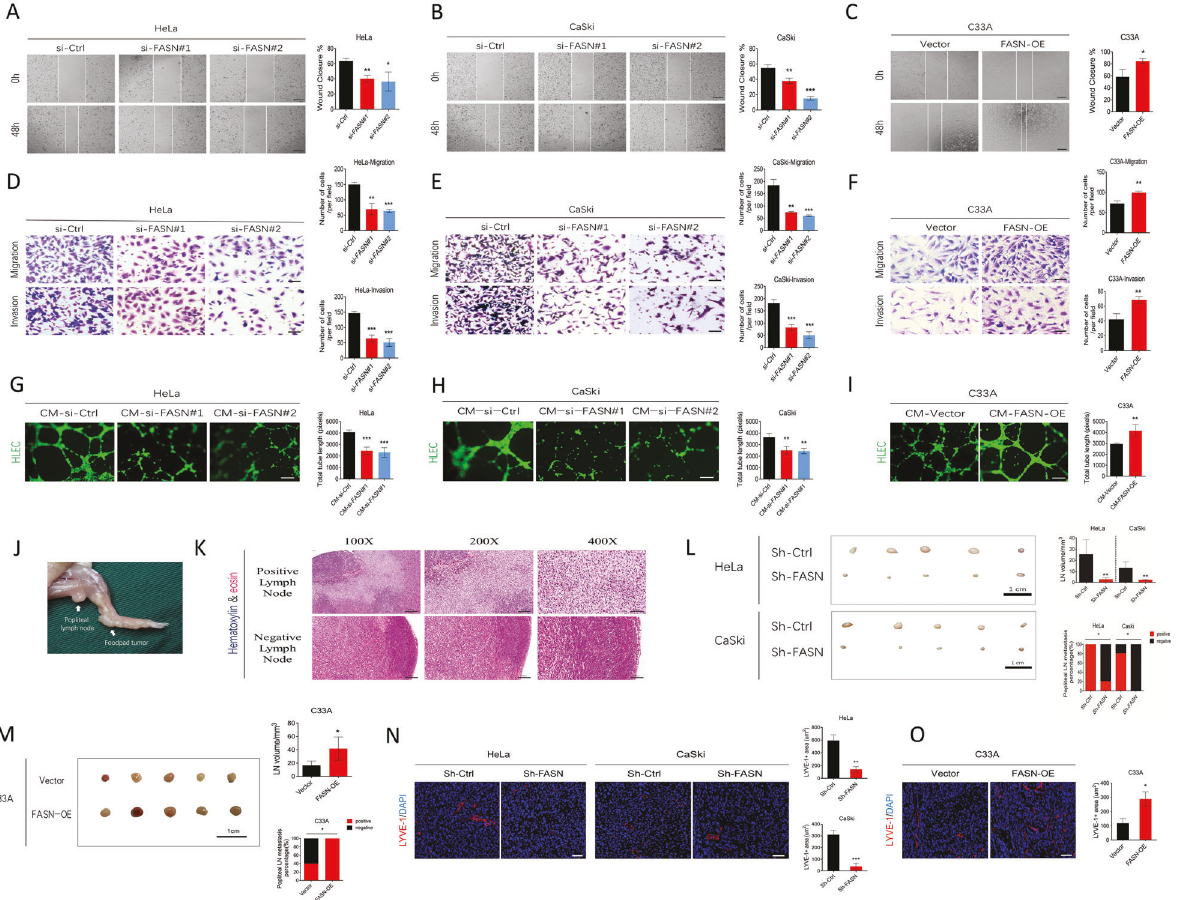
Fig. 3 FASN promotes cervical cancer cell migration, invasion, lymphangiogenesis in vitro, and lymph node metastasis in vivo. A , B The wound healing assay results and quanti fi cation in the si-FASN (siRNA#1 and #2) group and si-Ctrl (scramble siRNA) group of HeLa and CaSki cells. Bar = 200 µm. C The wound healing assay results and quanti fi cation in the Vector (empty vector plasmid) group and FASN-OE (FASN overexpression plasmid) group of C33A cells. Bar = 200 µm. D – F Transwell migration and invasion results and corresponding quanti fi cation in the same group settings as A-C in HeLa, CaSki, and C33A cells. Bar = 50 µm. G , H Assessment of lymphangiogenesis by tube formation assays in the CM-si-FASN (FASN siRNA#1 or #2-treated tumor culture medium) and CM-si-Ctrl (control scrambled siRNA-treated tumor culture medium) groups of HeLa and CaSki cells. Total tube length was quanti fi ed. Bar = 100 µm. I Tube formation assays performed in the CM-Vector and CM- FASN-OE groups of C33A cells. J . In vivo mouse model of CC lymph node metastasis. Arrow indicates the footpad tumor and popliteal lymph node. K Representative H&E staining images of positive and negative metastatic lymph nodes. Bar in 100×, 200×, 400 magni fi cations = 200 µm, 100 µm, 50 µm respectively. L Gross popliteal lymph node specimen and quanti fi cation of popliteal LN volume and